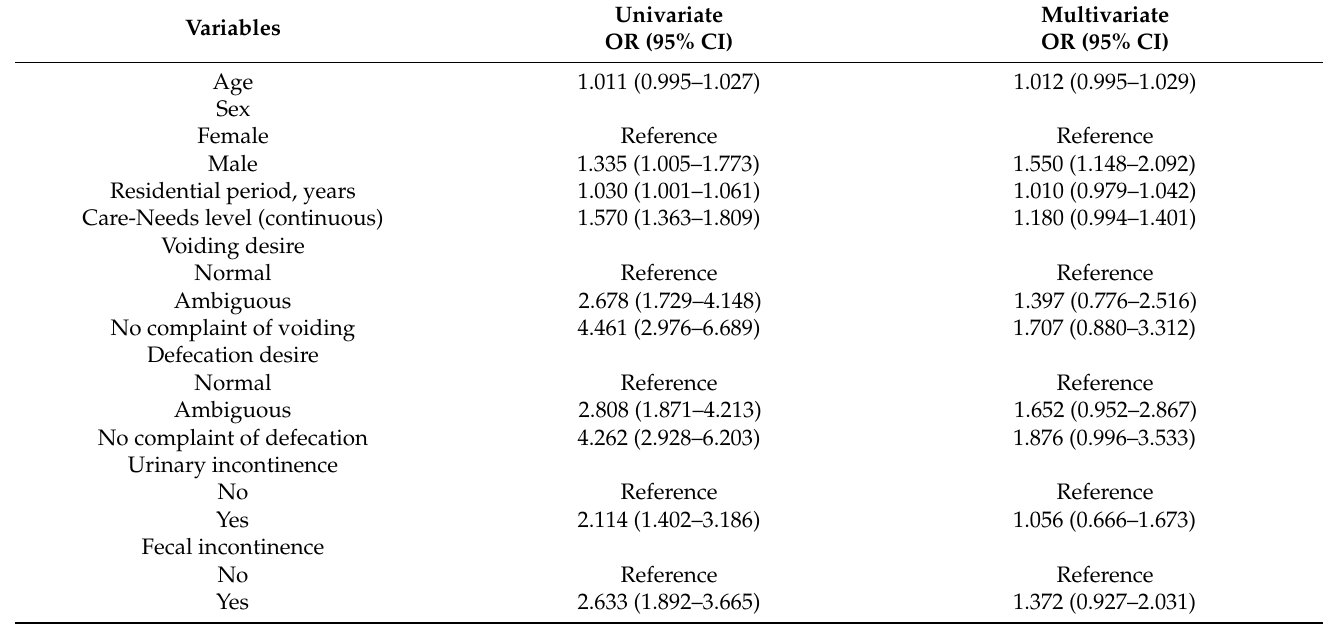
Table 5. Risk factors of pressure skin